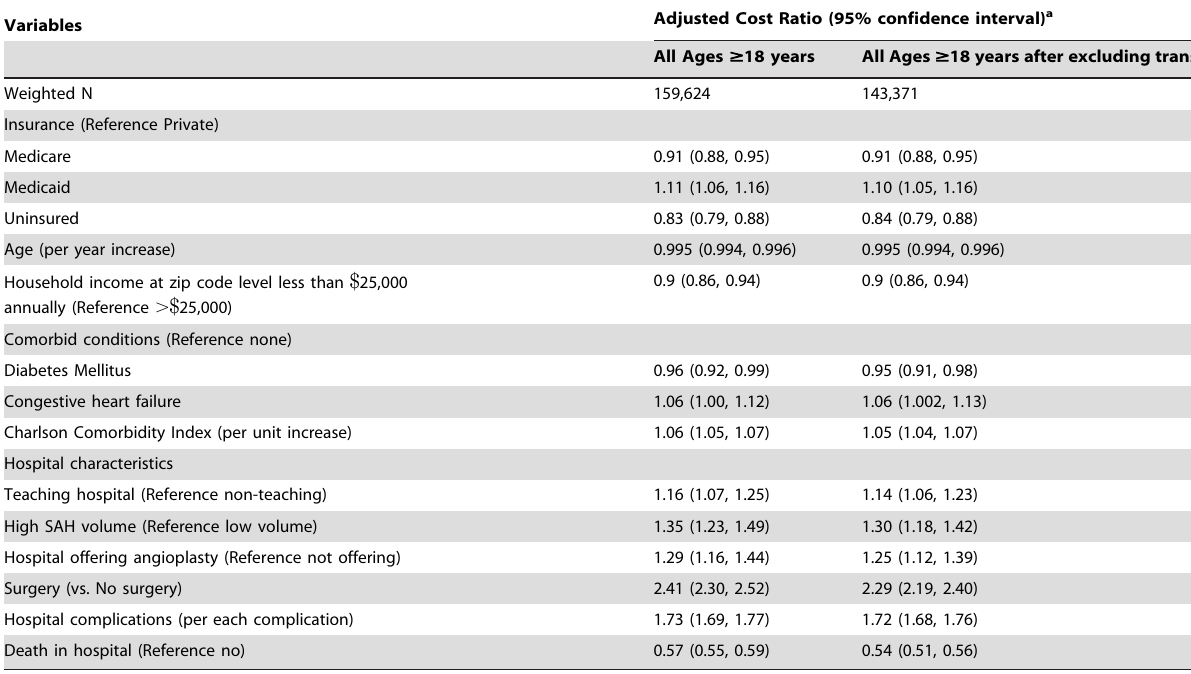
Table 4. Adjusted hospital cost ratios after subarachnoid